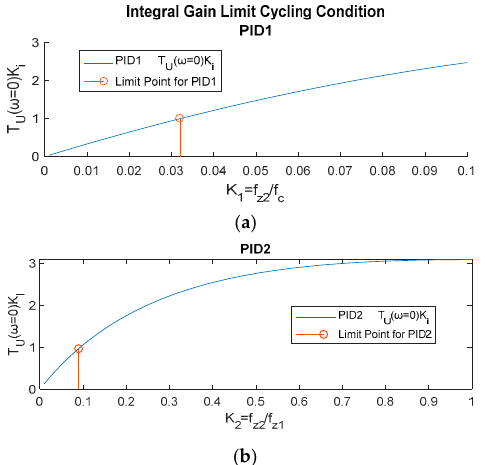
Figure 3. Analysis of the integral gain limit cycling condition for the PID1 (a) and PID2 (b) compensators.